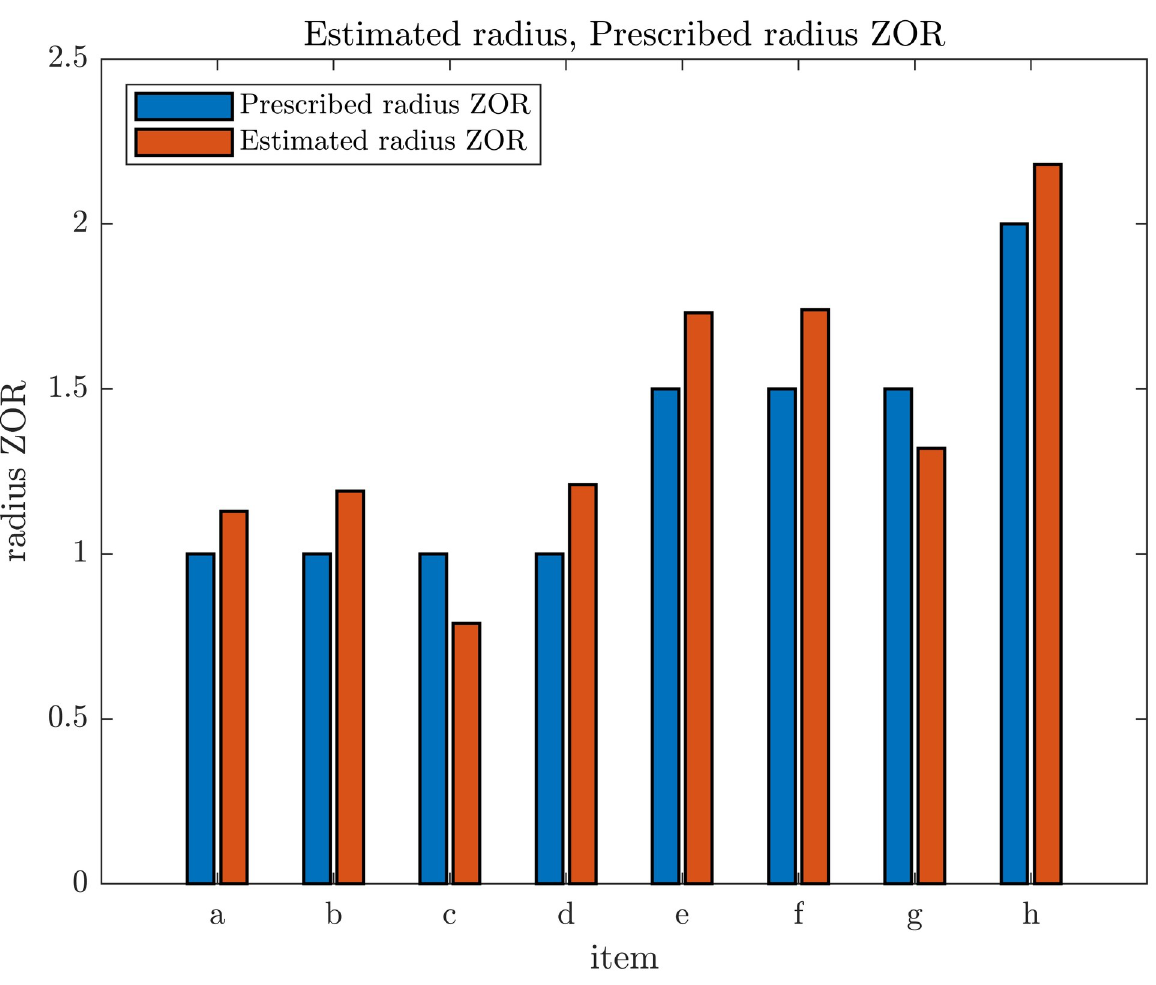
Fig 7. Comparsion of prescribed radii of the ZOR in simulations and the estimated radii of the same zones from the plots in Fig 2 & S28B- S31 Figs in S1 File. (Derived from simulations with N = 25 individuals over 1000 time steps).